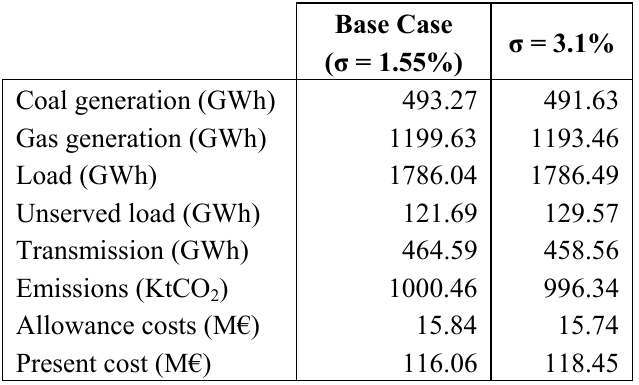
Table 5. Average generation, load, transmission, and costs ( 1 L ): Base case vs. higher load volatility.